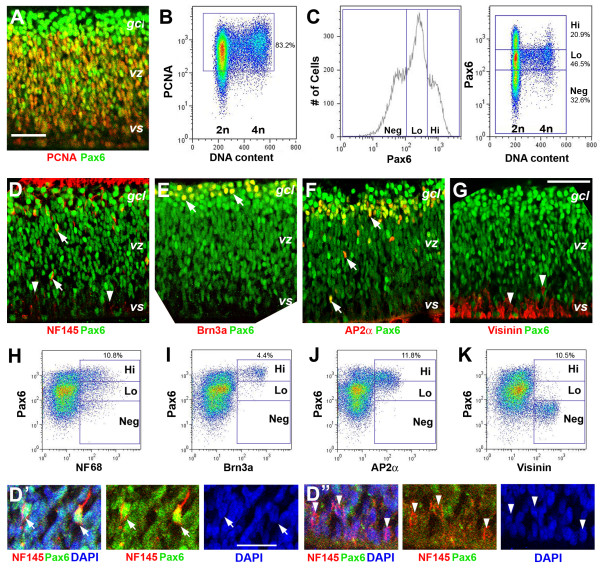
Distinct Pax6 expression levels among progenitors and postmitotic neurons. Immunocytochemical and flow cytometric analyses of neurogenic retinas. (A) Merged confocal image of PCNA (red) and Pax6 (green) co-labeled E6.5 (HH stage 30) retina. (B) Flow cytometry profile of E6 retinal cells based on PCNA signal and DNA content. The positions of 2n and 4n DNA contents indicate cells residing in the G1/G0 (2n) or G2/M (4n) phase. S phase cells are positioned between 2n and 4n along the DNA content axis. PCNA+ cells (boxed, 83.2% of total cells) are distributed throughout the cell cycle. (C) Flow cytometry profiles for Pax6 levels of total cells (left panel) and Pax6 versus DNA content (right panel) at E7 (HH stage 32). Blue lines delineate Pax6Hi (20.9%), Pax6Lo (46.5%), and Pax6Neg (32.6%) cell popuations. (D-G) Merged confocal images of E6.5 (HH stage 30) retinas co-labeled for Pax6 and NF145 (D), Brn3a (E), AP2α (F), or Visinin (G). (D', D") Higher magnification images of NF145 and Pax6 co-labeling near the ventricular surface. Arrows indicate co-labeled cells. Arrowheads point to marker-positive but Pax6-negative cells. (H-K) Flow cytometry profiles of Pax6 and NF68 (H), Brn3a (I), AP2α (J), and Visinin (K) at E7 (HH stage 32). Boxed regions delineate distribution of neuronal marker-positive cells according to Pax6 levels. Percentages of marker-positive cells among total cells are shown above the boxes. gcl, ganglion cell layer; vs, ventricular surface; vz, ventricular zone. Scale bars: 100 μm in (A, G), which applies to (D-G); 50 μm in (D'), which applies to (D', D").